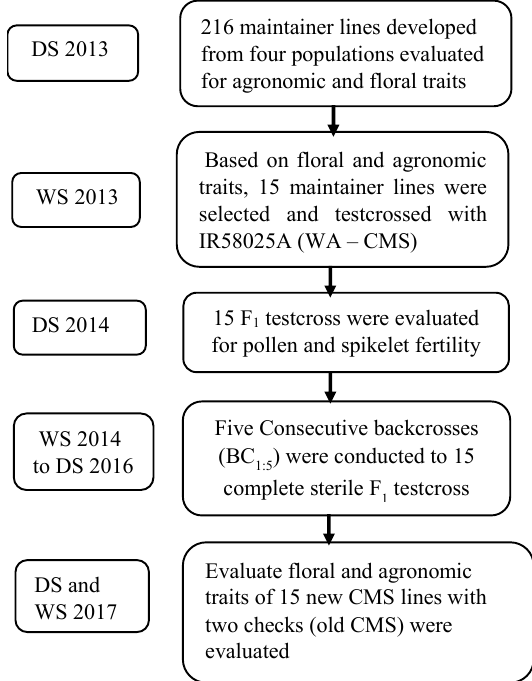
Figure 1. Scheme of evaluation of maintainer lines and developing new cytoplasmic male sterility (CMS) lines in dry (DS) and wet (WS) seasons at Saint Louis, Senegal. (CMS) lines in dry (DS) and wet (WS) seasons at Saint Louis,